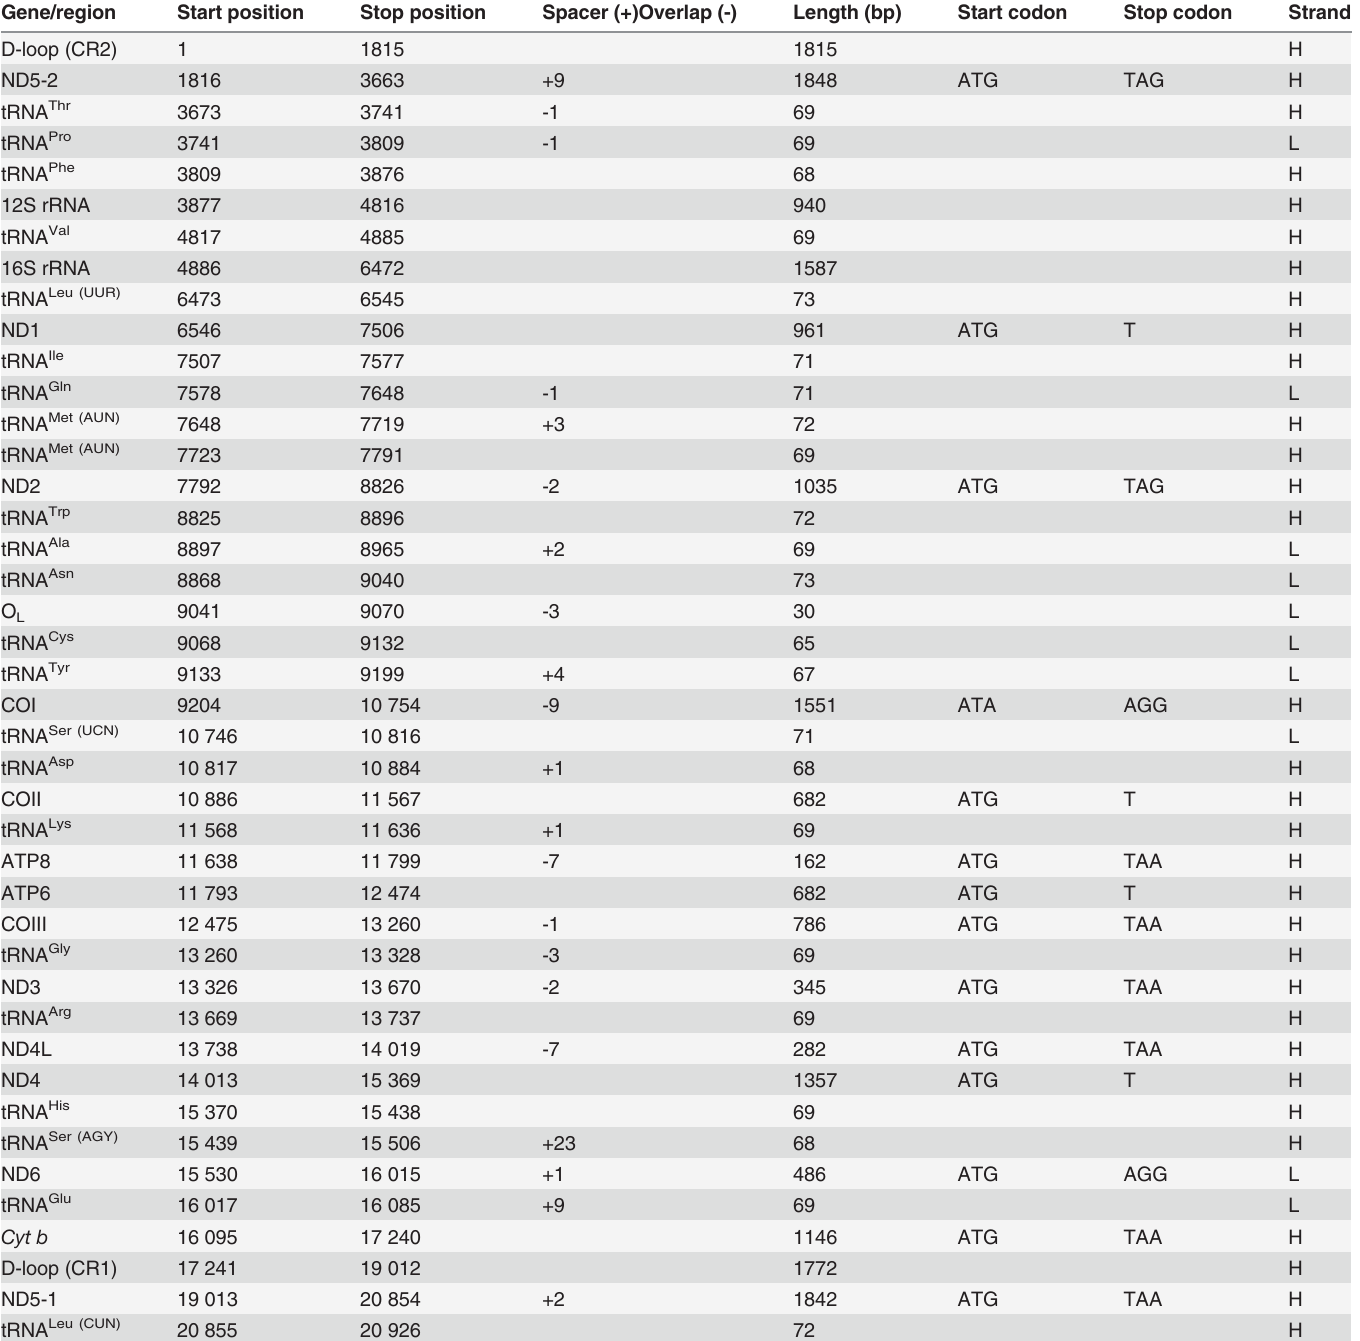
Table 2. Location of features in the mtDNA of H . rugulosus (BT).